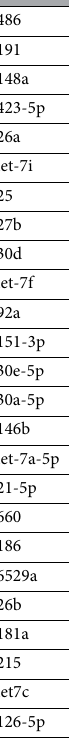
Table 1. The 25 most expressed miRNAs in blood plasma samples.